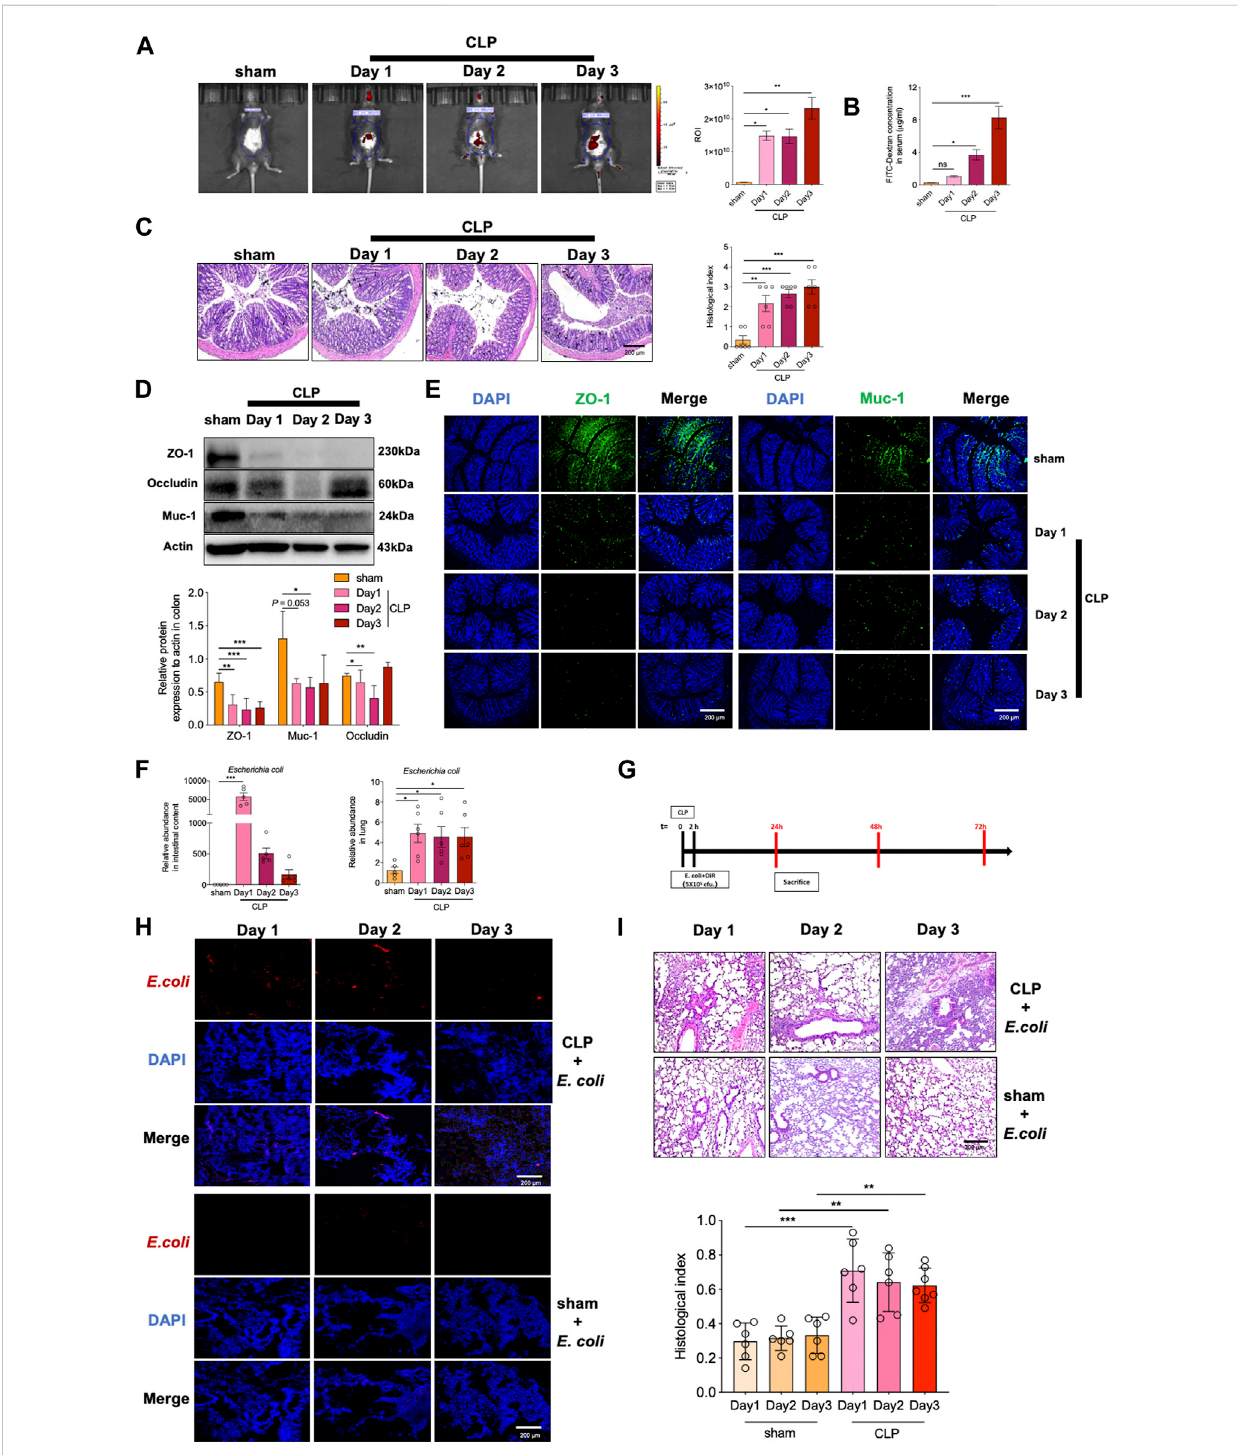
FIGURE 5 Sepsis causes impaired intestinal barrier and gut-lung translocation of E. coli to induce lung pathology. Intestinal permeability was determined by measuring (A) fl uorescence intensity of FITC-dextran and (B) serum FITC-dextran concentration. (C) H&E staining of colon tissues and correlated pathological scores (magni fi cation: ×400, scale bar = 200 μ m); (D) Immunoblotting of ZO-1, Occludin and Muc-1; (E) immuno fl uorescent staining of ZO-1 and Muc-1; (F) Relative abundance of (E) coli in intestinal contents and lung tissues; (G) DiL-labeled E. coli was given rectally to mice (10 6 CFU permouse),and2 hlater,themiceweresubjectedtoCLP; (H) FrozensectionoflungtissueswasdetectedforDiL-labeled E.coli ; (I) H&Estainingoflungs and correlated pathological scores (magni fi cation: ×400, scale bar = 200 μ m) (mean ± SD, n = 5 or 6; * p < 0.05, ** p < 0.01, *** p <